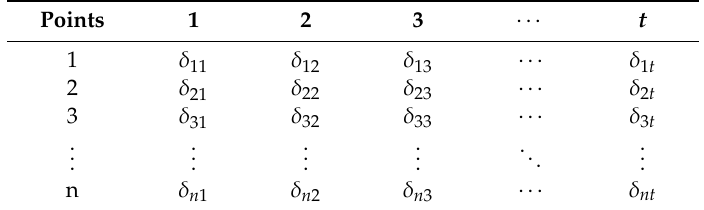
Table 3. Panel data structure.